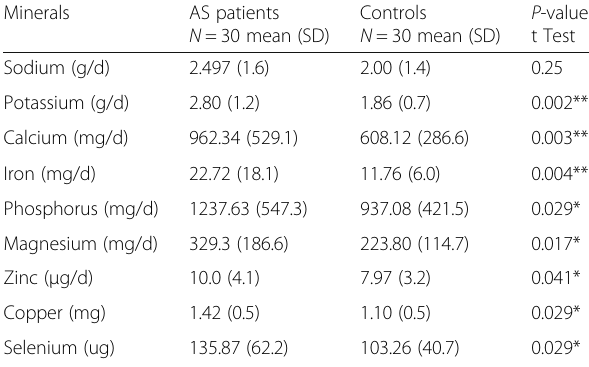
Table 4 Dietary intake of minerals in AS and healthy groups Minerals AS patients Controls N = 30 mean (SD) N = 30 mean (SD)